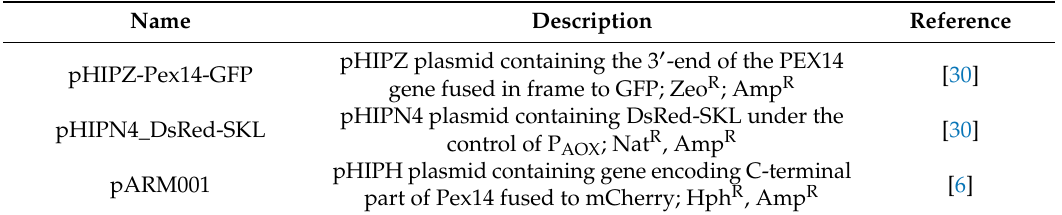
Table 2. Plasmids used in this study.